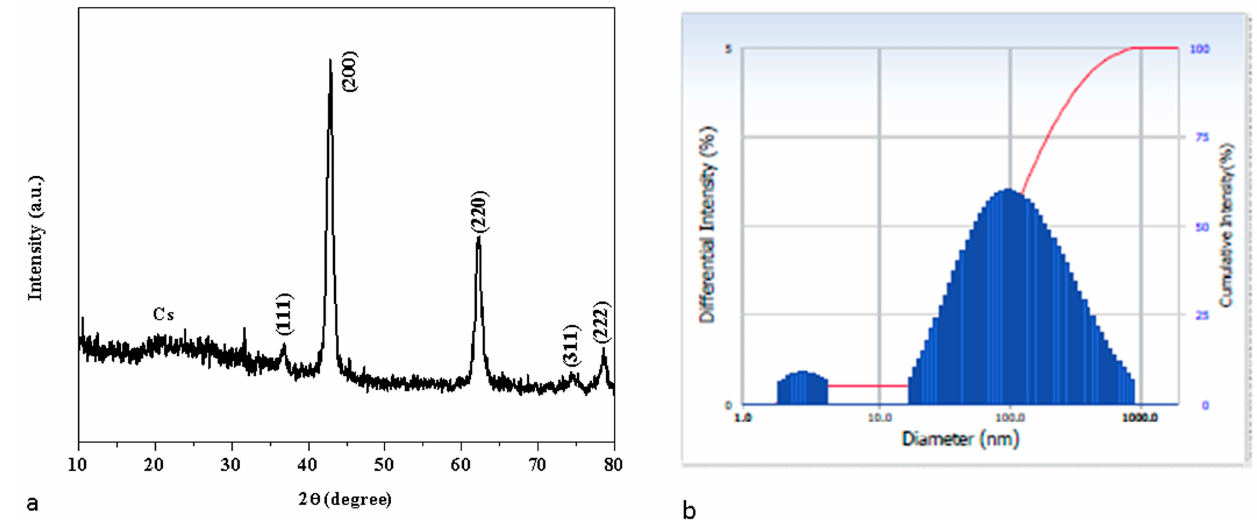
Figure 2. XRD Pattern of MgO-Chitosan-Pluronic F127-Escin NPs ( a ). Number-weighted particle size distribution obtained by DLS ( b ).